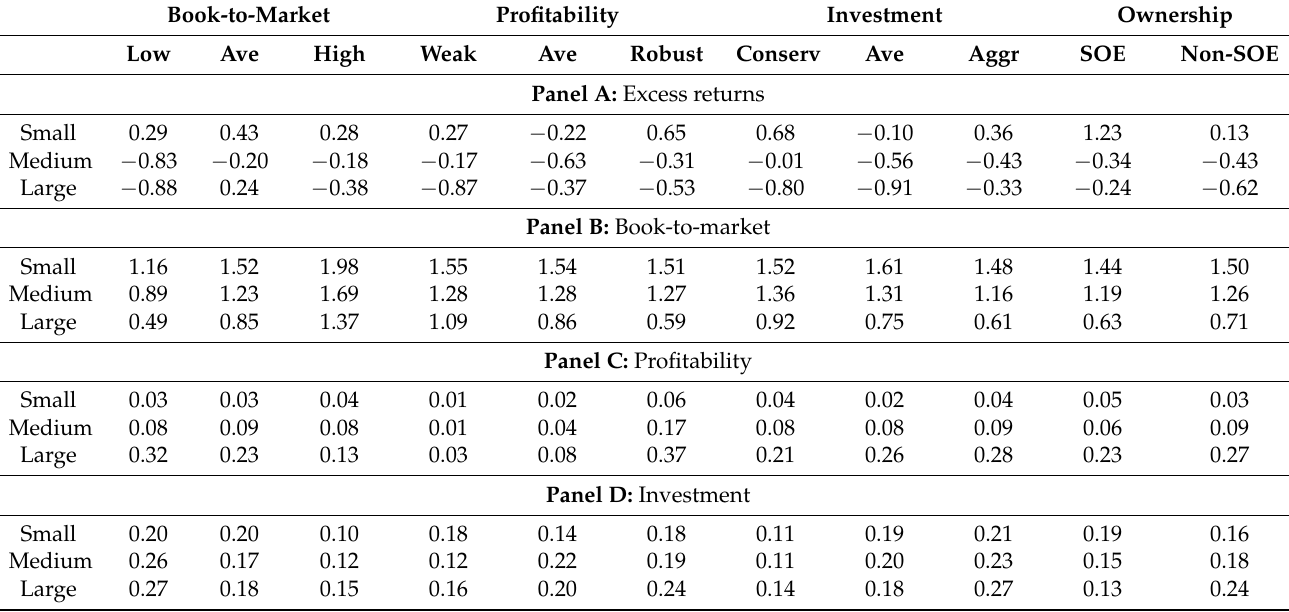
Table 4. Characteristics of double-sorted portfolios. The table provides time-series averages of average percentage monthly excess returns, book-to-market, profitability and investment ratios in July of year t to June of year t + 1 for portfolios formed in December of year t − 1 on double sort of size and a combination of book-to-market, profitability and investment. The portfolio formation and book-to-market, profitability and investment ratios follow Fama and French (2015) methodology. Each of the ratios for a portfolio in a given year is the value-weighted average of the ratios for the firms in the portfolios. Firms in the columns ownership are sorted by size and ownership structure. Panel ( A ) provides time-series averages of monthly returns in excess of Vietnam’s interbank offer rate (in percentages). Panel ( B – D ) show the book-to-market, profitability and investment times-series averages for a portfolio. Column Low (below Book-to-market) shows the characteristics of portfolios of stocks sorted by size (small, medium and large) and low book-to-market ratio. Column Ave shows the characteristics of the portfolios of stocks sorted by size (small, medium and large) and average book-to-market ratio. Column High shows the characteristics of the portfolios of stocks sorted by size (small, medium and large) and high book-to-market ratio. Column Weak (below profitability) shows the characteristics of portfolios of stocks sorted by size (small, medium and large) and low profitability ratio. Column Ave shows the characteristics of portfolios of stocks sorted by size (small, medium and large) and average profitability ratio. Column Robust shows characteristics of portfolios of stocks sorted by size (small, medium and large) and high profitability ratio. Column Conserv (below investment) shows characteristics of portfolios of stocks sorted by size (small, medium and large) and low investment ratio. Column Ave shows characteristics of portfolios of stocks sorted by size (small, medium and large) and average investment ratio. Column Aggr shows characteristics of portfolios of stocks sorted by size (small, medium and large) and high investment ratio. The sample is from September 2008 to July 2015.